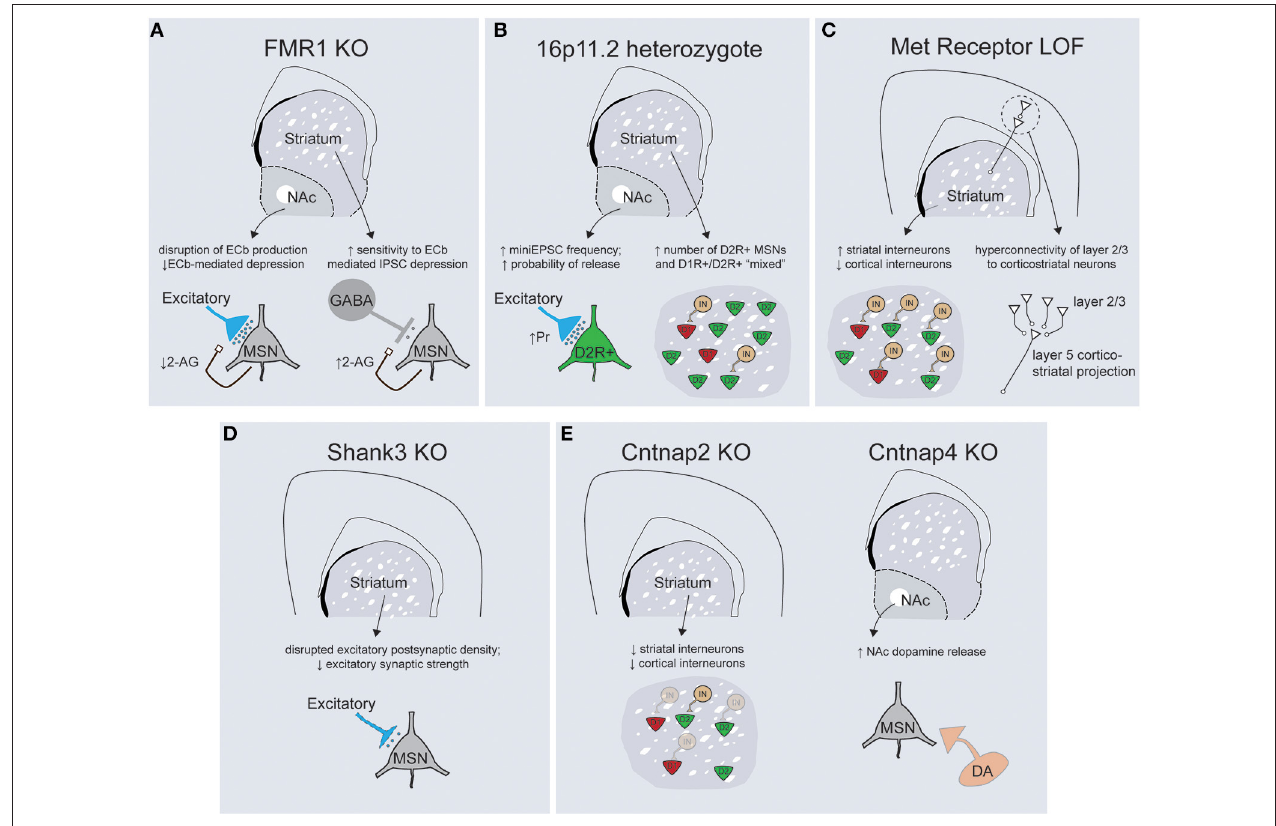
FIGURE 3 | Mouse models of ASD-associated genes display abnormalities in striatal structure and function. (A) FMR1 KO mice display abnormalities in the regulation of endocannabinoid signaling within the striatum, with decreased 2-arachidonylglycerol (2-AG) production in the NAc leading to altered plasticity of excitatory inputs (left) and increased 2-AG production in the dorsal striatum enhancing depression of inhibitory transmission onto dorsal striatal MSNs (right). (B) 16p11.2 heterozygotes exhibit an increase in excitatory synaptic transmission onto D2R + MSNs of the NAc (left) while both the dorsal and ventral striatum have larger overall numbers of D2R + MSNs (right). (C) Loss of Met receptor function within ventral telencephalic progenitors leads to an increase in the number of parvalbumin and somatostatin-positive striatal interneurons at the expense of cortical interneuron populations (left). Met receptor KO mice display enhanced connectivity of superficial layer cortical neurons that synapse on corticostriatal projection neurons (right). (D) Shank3 KO mice exhibit gross abnormalities in synaptic structure, alterations in the protein architecture of synapses and a decrease in general excitatory synaptic strength within the dorsal striatum. ( E , left) Cntnap2 KO mice exhibit deficits in migration of interneuron progenitors such that striatal interneuron populations are decreased. Cntnap4 KO mice demonstrate enhanced release of dopamine specifically within the nucleus accumbens